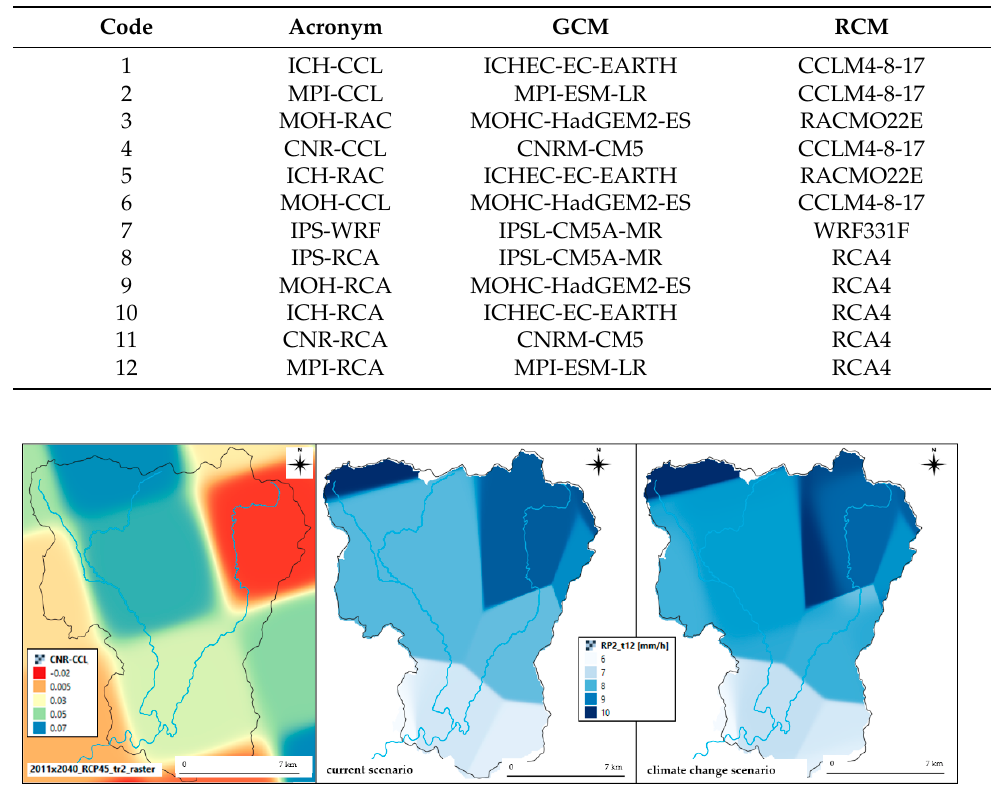
Table 1. Ensemble of the 12 climate models considered in the analysis.